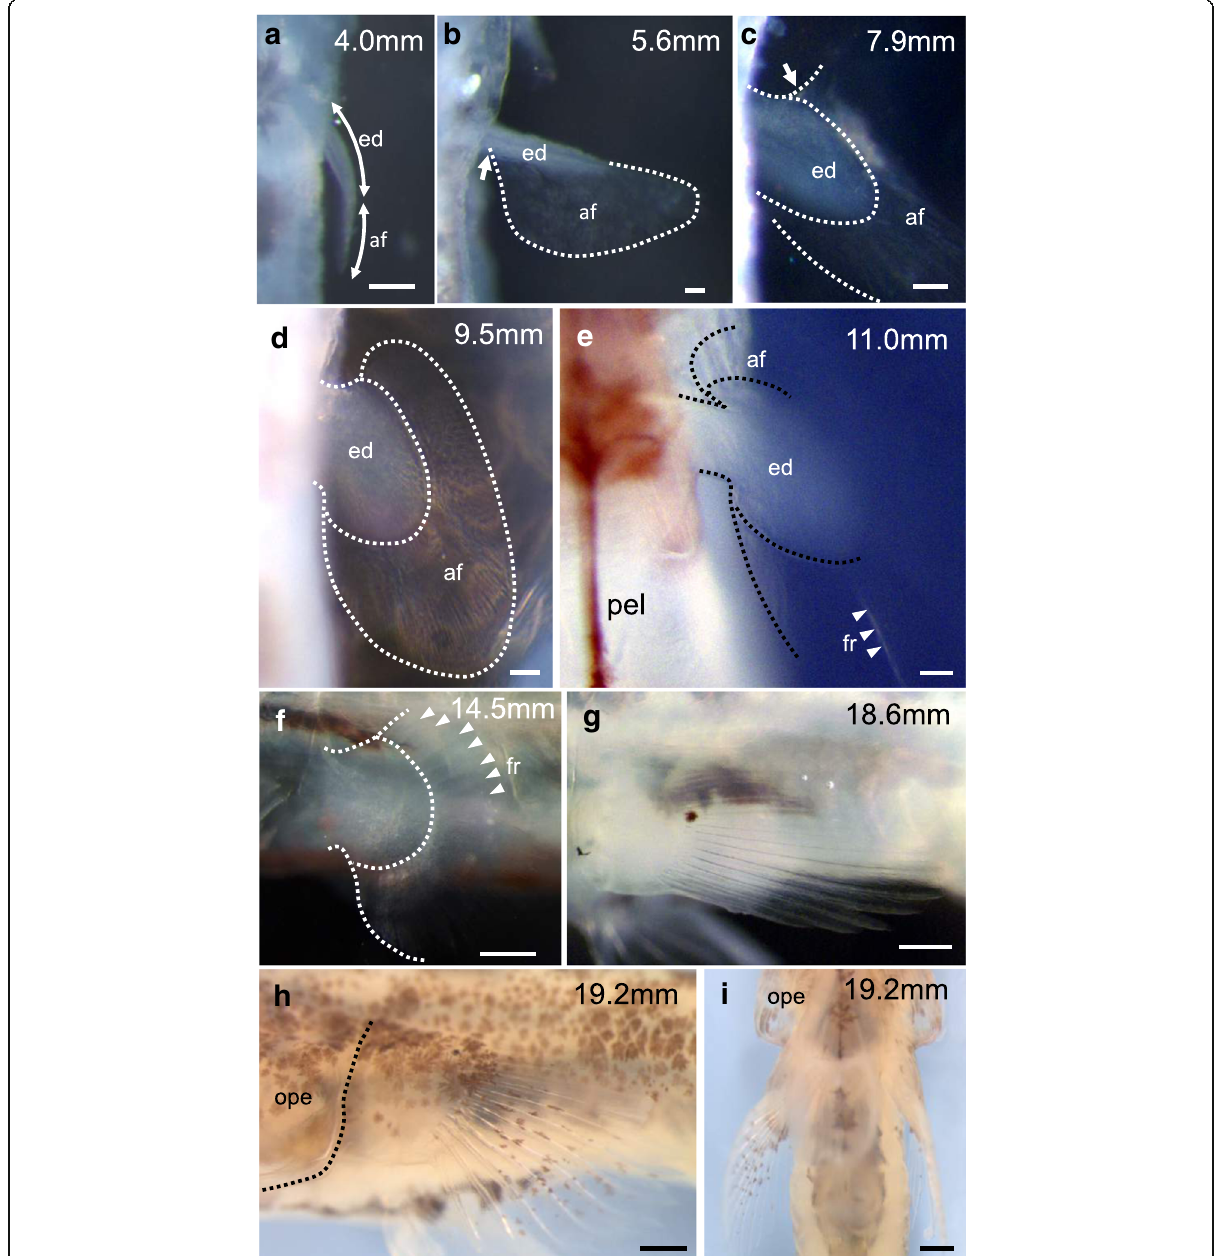
Fig. 4 Development of the pectoral fins of mudskipper larvae and juveniles. Dorsal ( a – d ), ventral ( e , i ), and lateral views ( f – h ) views of planktonic larvae at TL 4.0 – 14.5 mm stages ( a – f ; n = 1 each stage) and benthic to amphibious juveniles at TL 18.6 – 19.2 mm stages ( g – i ; n = 1 each stage). Arrows in ( b , c ) indicate the boundary between the endoskeletal disc and the fin fold. Arrowheads in ( e , f ) indicate fin rays. af, apical fin fold; ed, endoskeletal disc; fr, fin ray; ope, operculum; pel, pelvic fin. Scale bars, 100 µm in a-e; 500 µm in f –